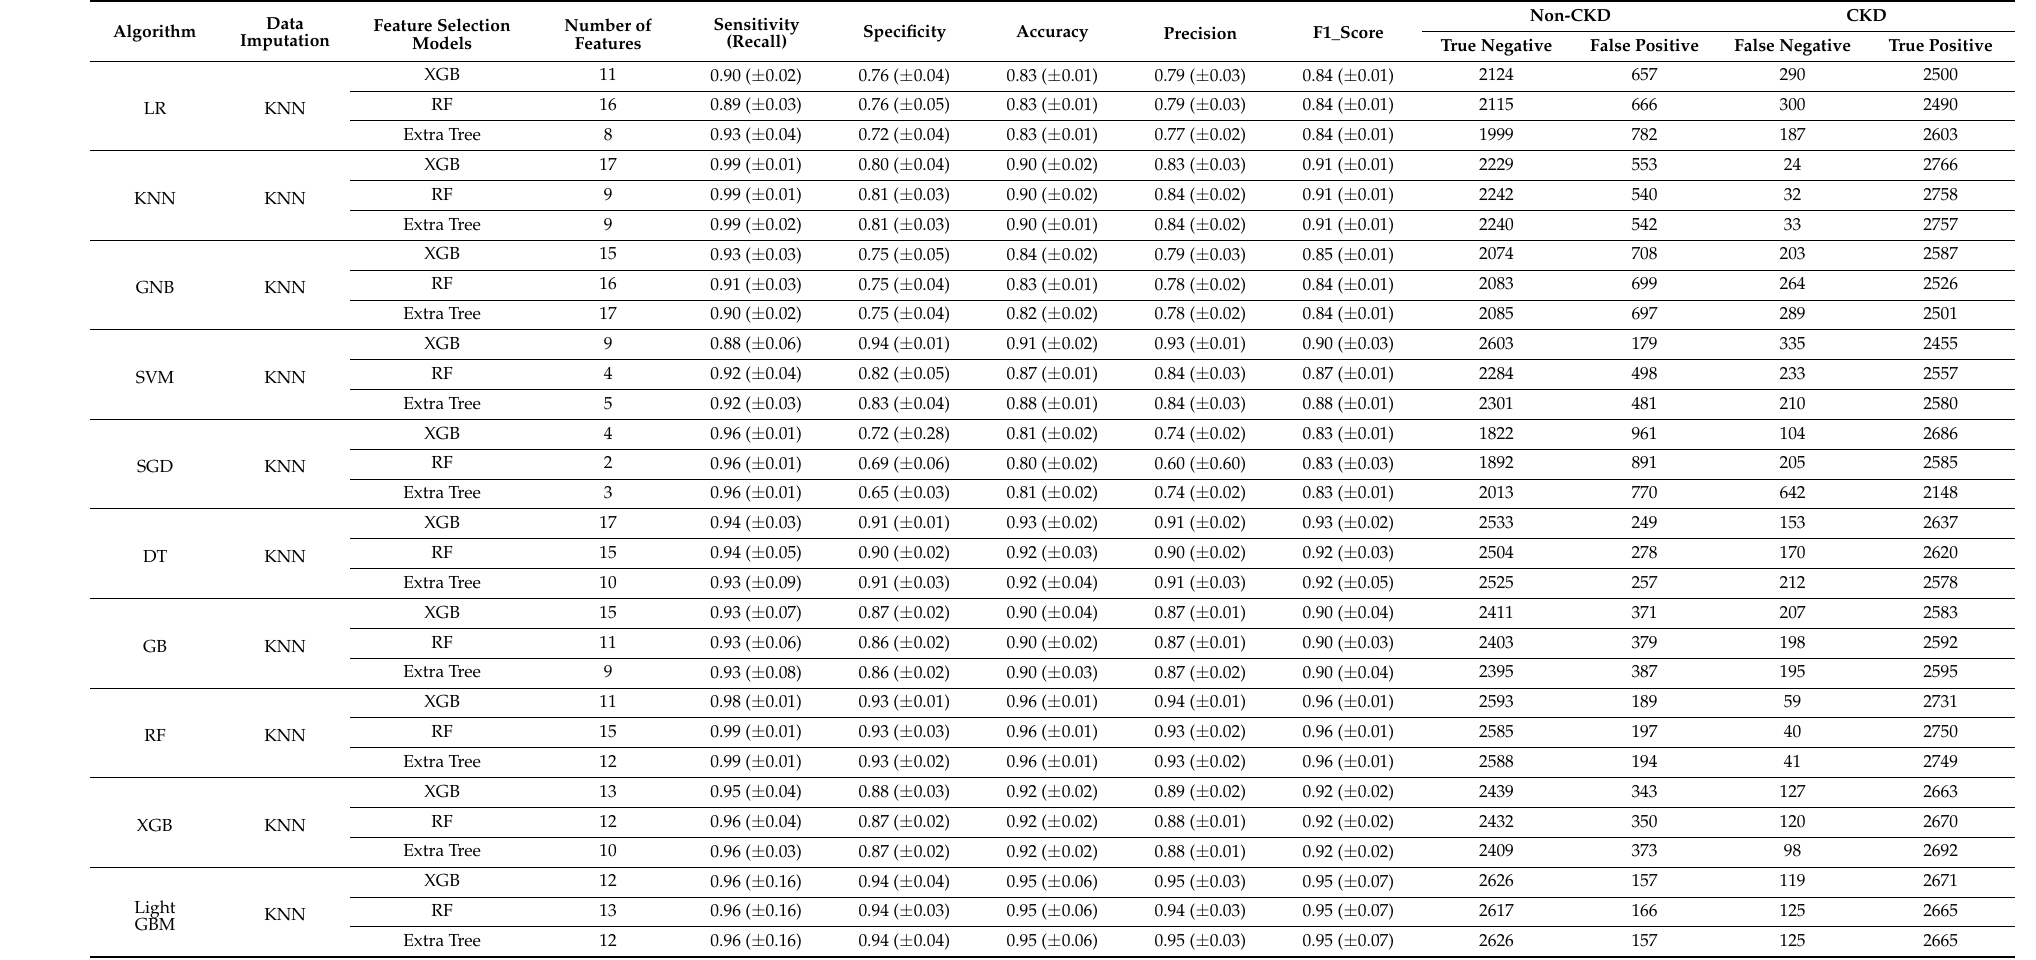
Table 3. Comparative performance analysis of different ML